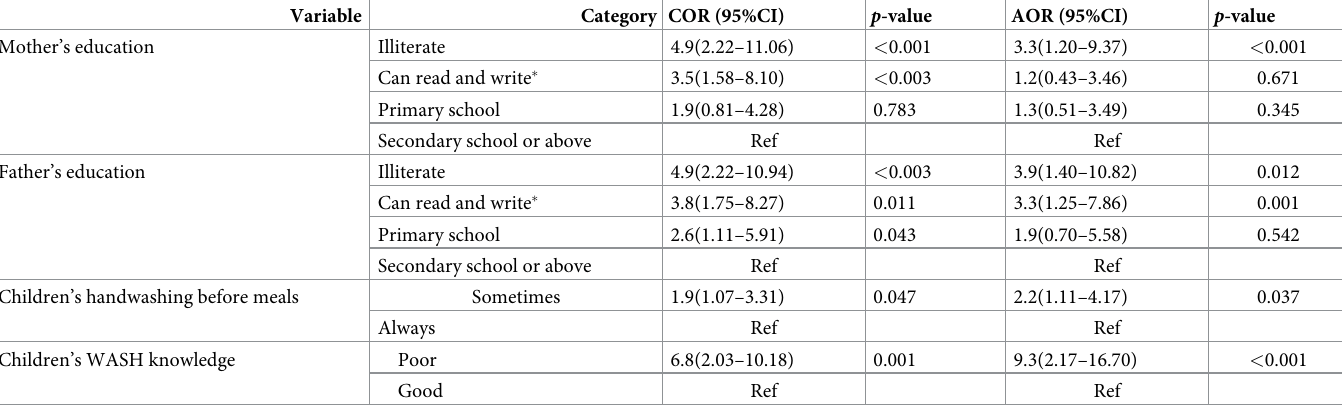
Table 4. Factors associated with intestinal parasitosis among primary school children from multivariable logistic regression